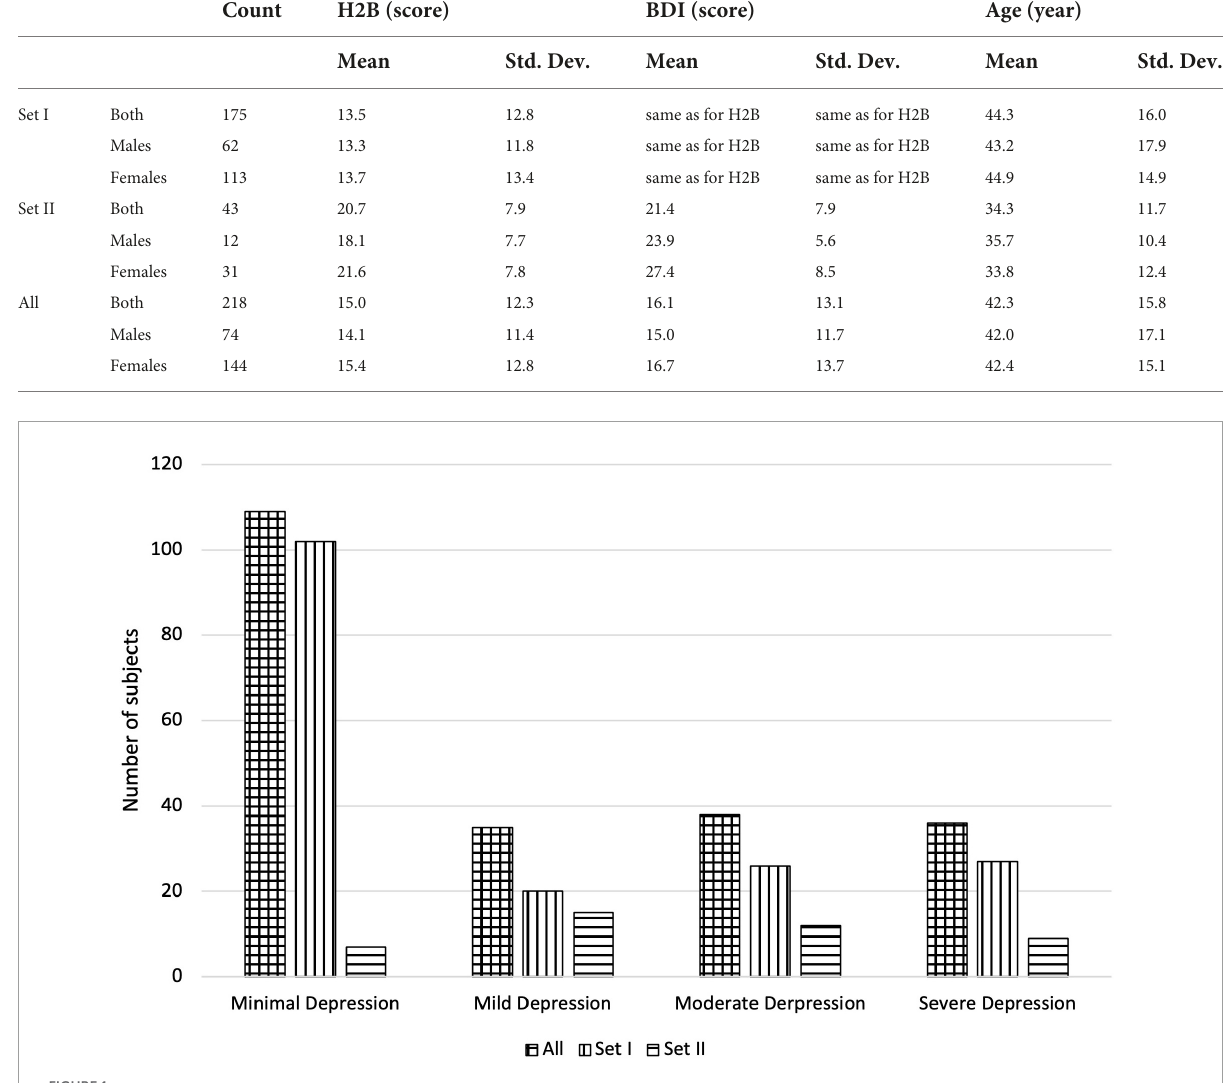
FIGURE1 Number of subjects of the applied Depressed Speech Database by H2B category in the case of All, Set I, and Set